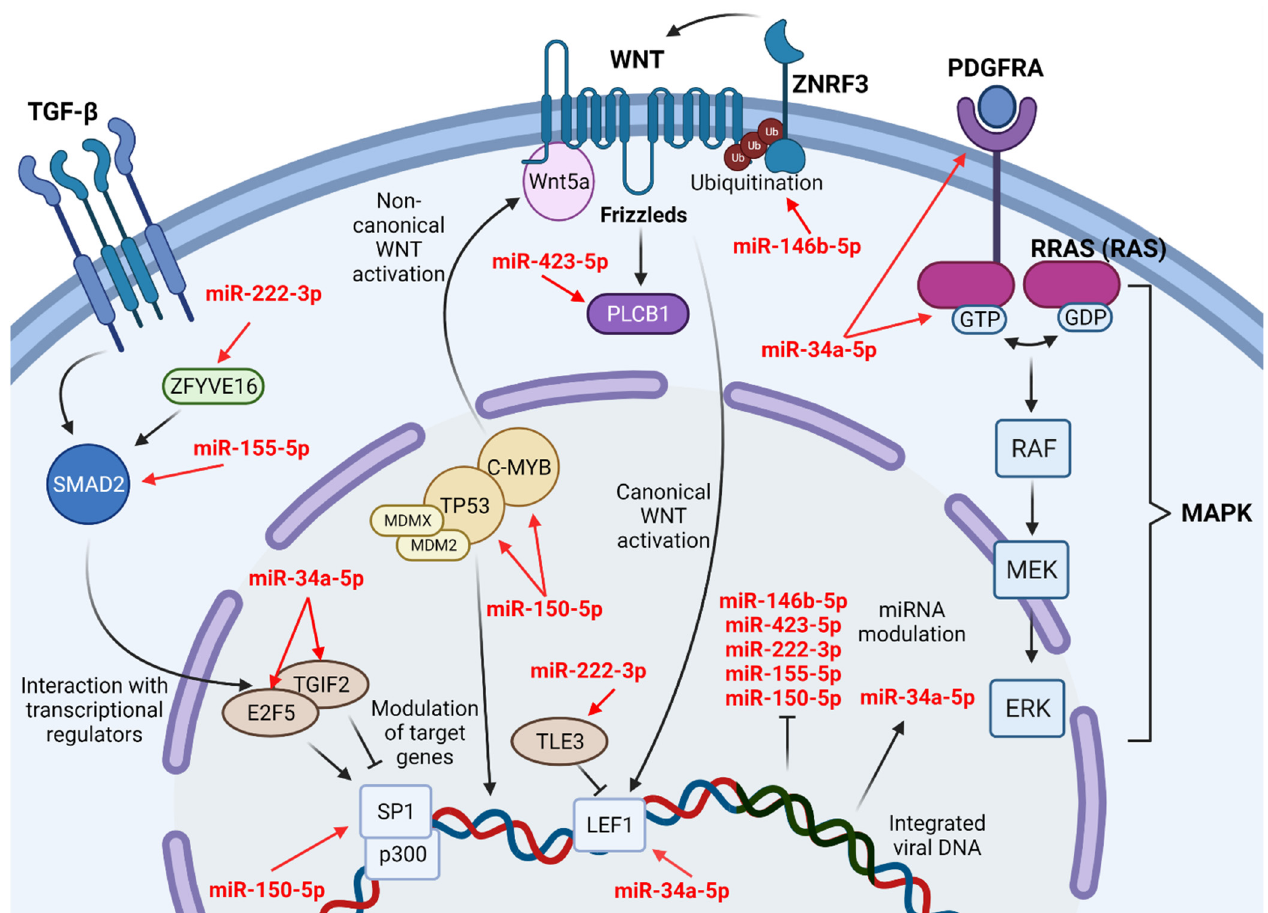
Figure 3. MiRNAs interactions on cellular pathways modulated by HTLV-1 infection driving ATL onset. MiR-34a-5p is an upregulated and extremely relevant miRNA in HTLV-1 cell interactions. Most other miRNAs appear to be downregulated and have a wide range of modulation activity over pathway inhibitors and enhancers. MiR-150-5p interacts directly with TP53 activity and may regulate its activities after oncogenic gains of function. ATL cells also present a preference for WNT non- canonical pathway activation, with downregulation of canonical pathway activity through miRNA modulation and Wnt5a competitive binding. Furthermore, HTLV-1 infected cells also differently express miRNAs involved in the regulation of many other important cell pathways, such as TGF- β , RAS, and MAPK.